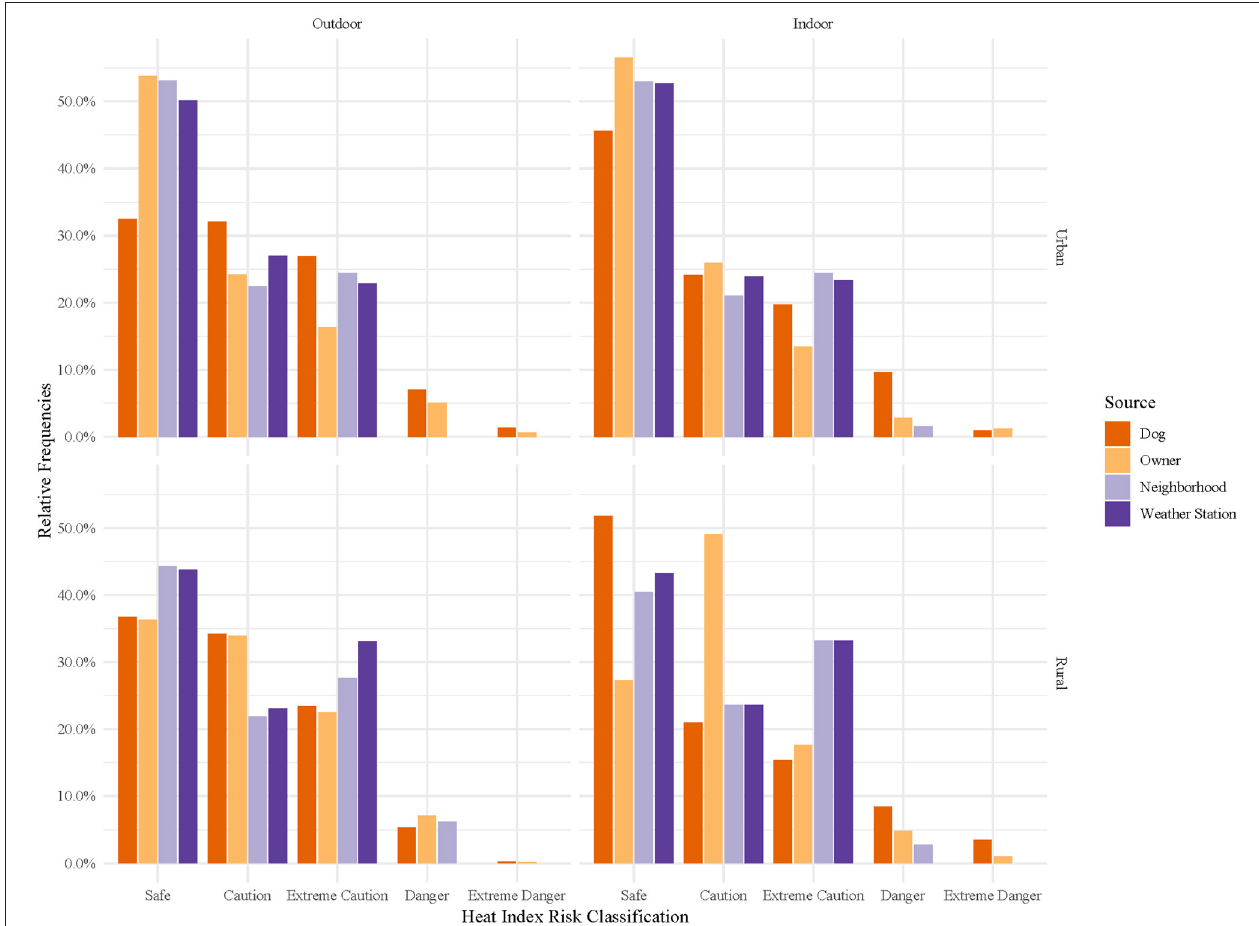
FIGURE 6 | Relative frequencies of hourly heat index risk classification calculated for canine pets’ thermometers, owners’ thermometers, neighborhood weather stations, and nearest weather station, stratified by home environment (outdoor or indoor) and location (urban or rural). Heat index risk classifications were determined by the National Weather Service’s designations: Safe ( < 80 ◦ F), Caution (80–90 ◦ F), Extreme Caution (90–103 ◦ F), Danger (103–124 ◦ F), and Extreme Danger ( ≥ 125 ◦ F)